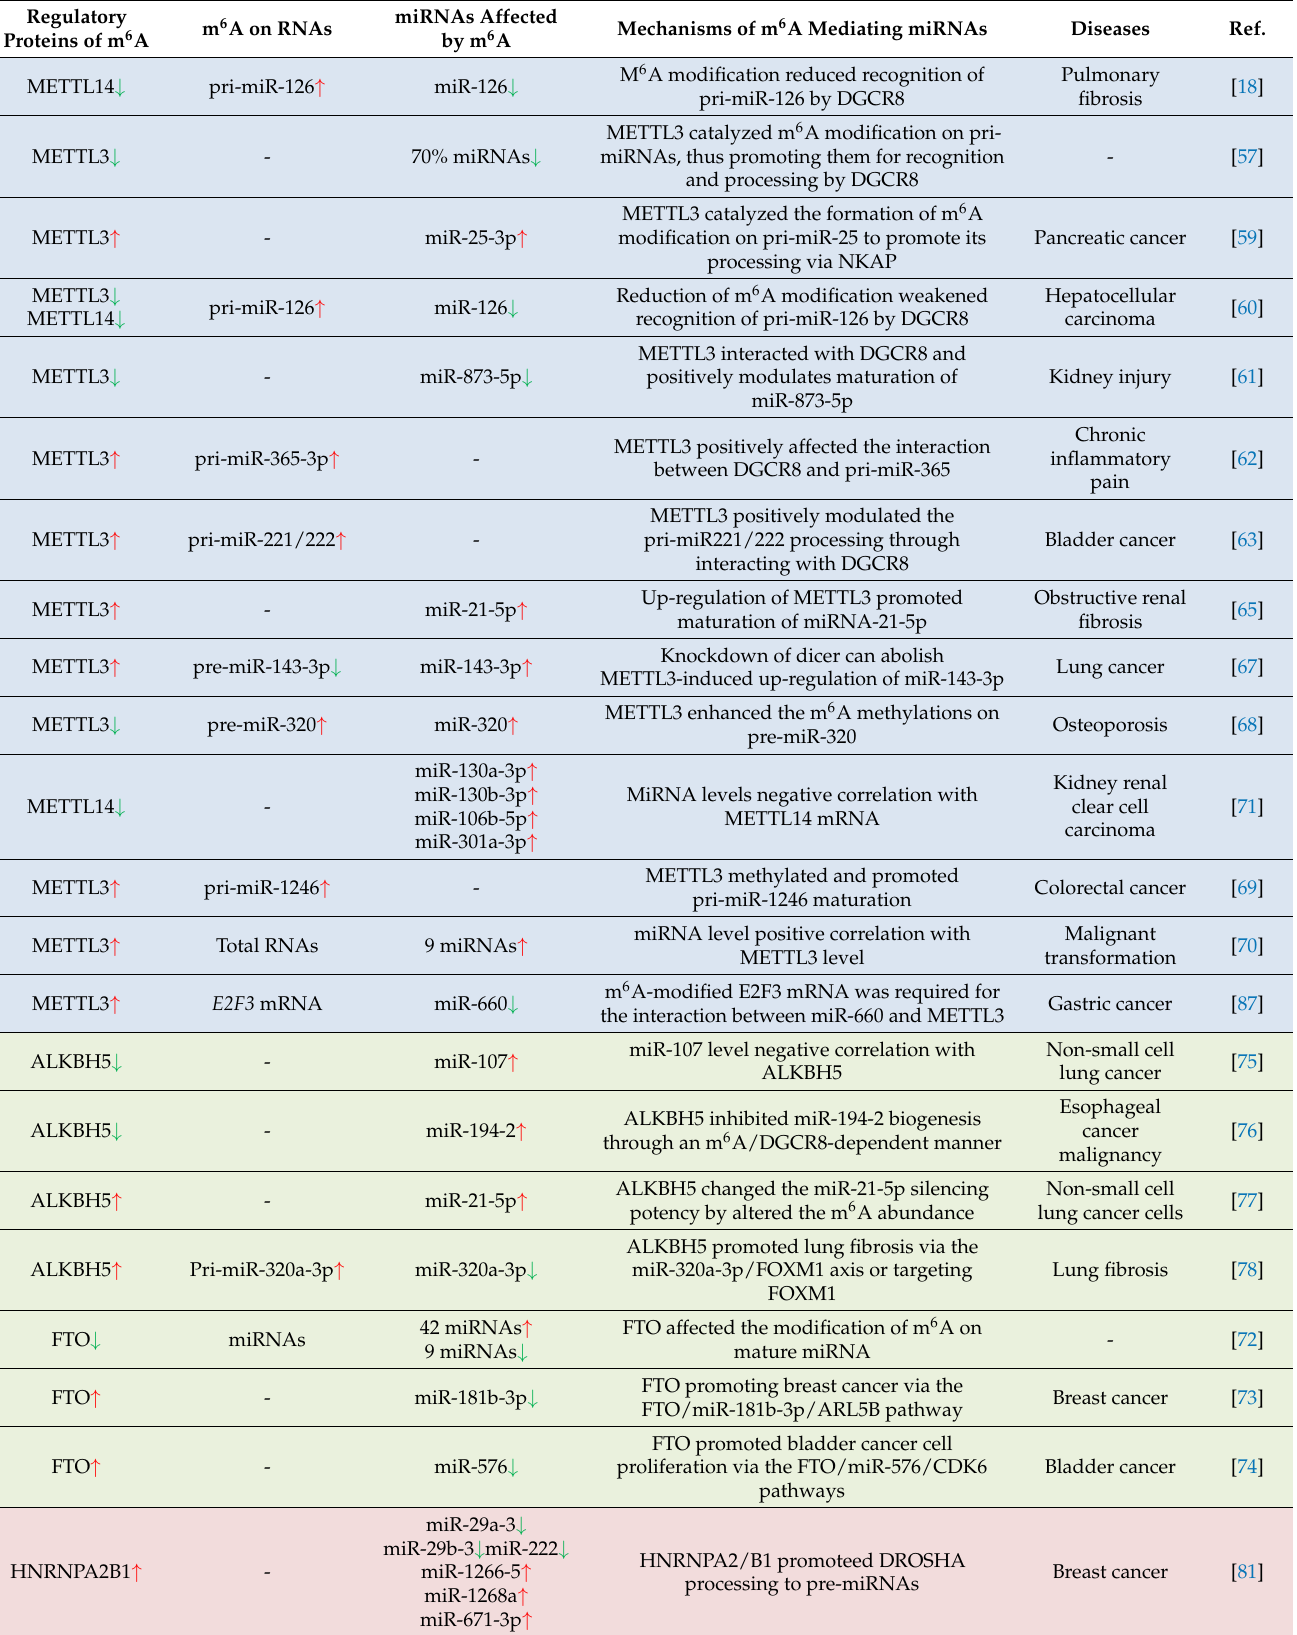
Table 1. m 6 A modification involves in regulation of miRNA